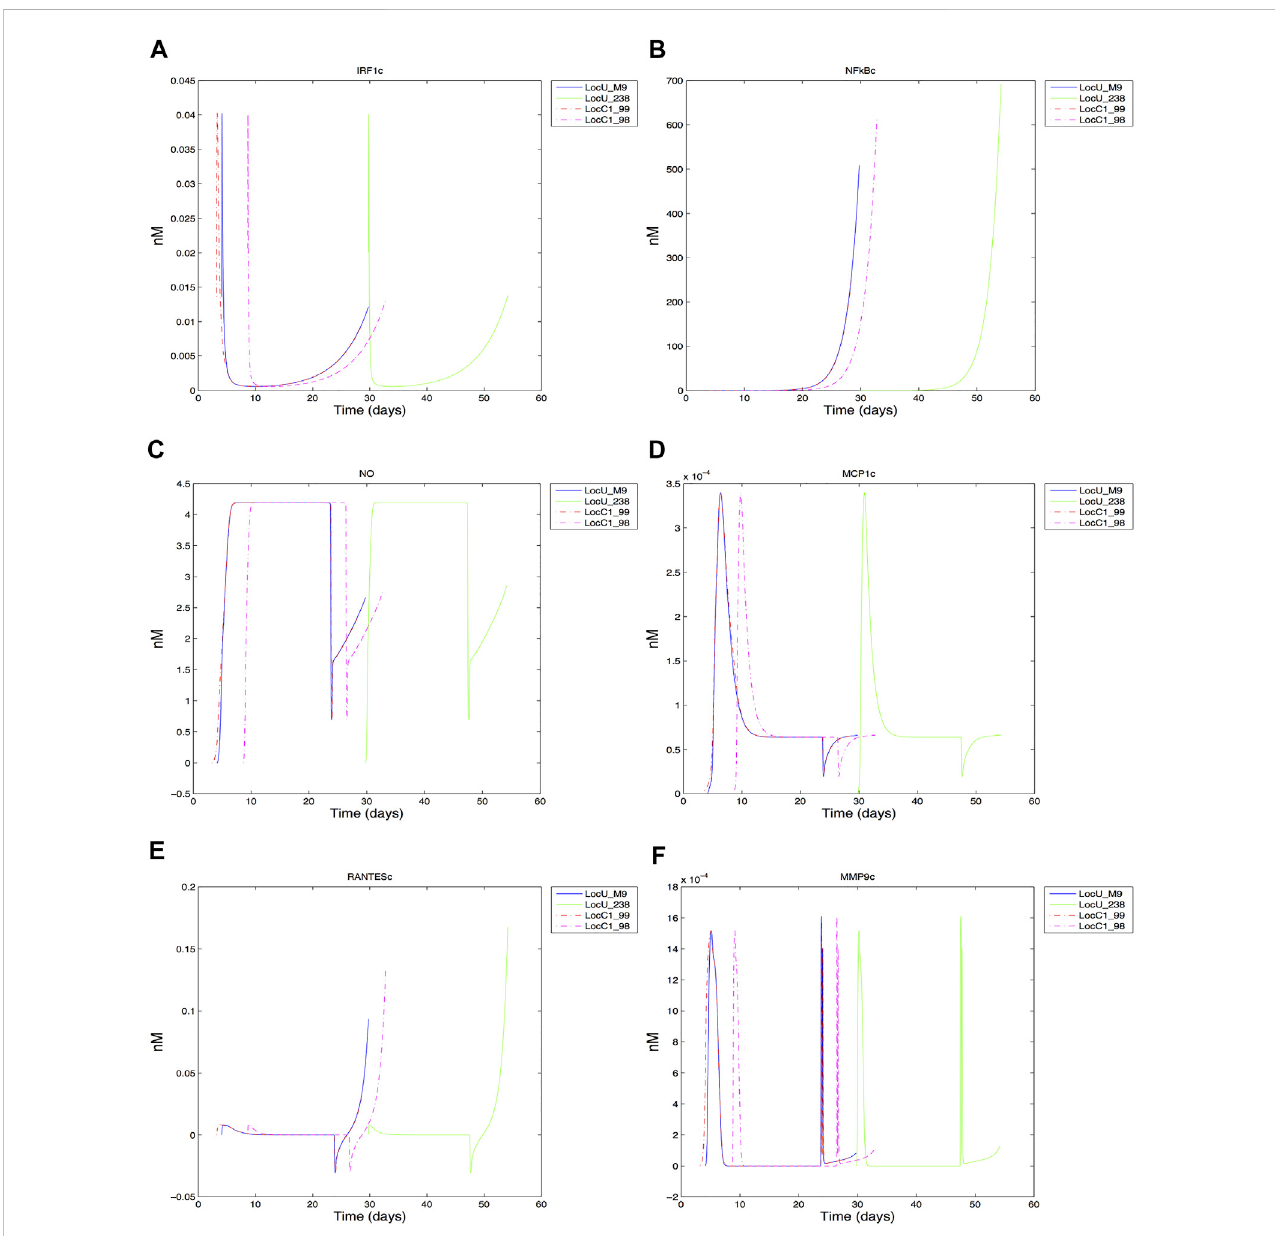
FIGURE 8 Response of center grid cell associated macrophages: (A) IRF1 cytoplasmic (B) NFkB cytoplasmic (C) Nitric oxide cytoplasmic (D) MCP1 cytoplasmic (E) RANTES cytoplasmic (F) MMP9 cytoplasmic.